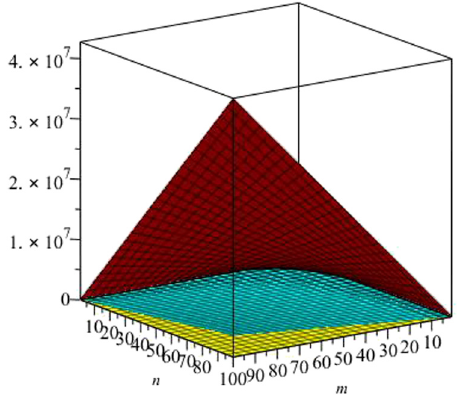
Figure 7: Comparison of second K - Banhatties